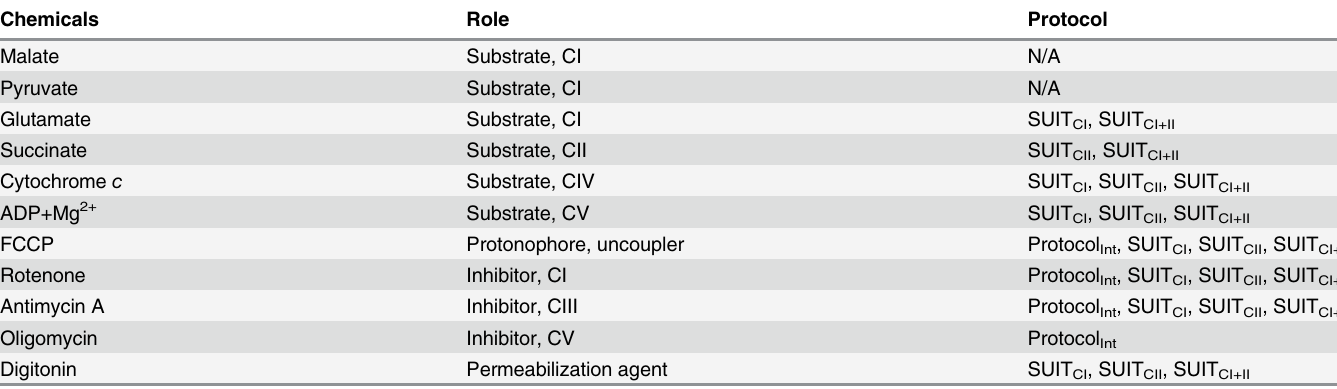
Table 1. Reagents used in the different high-resolution respirometry